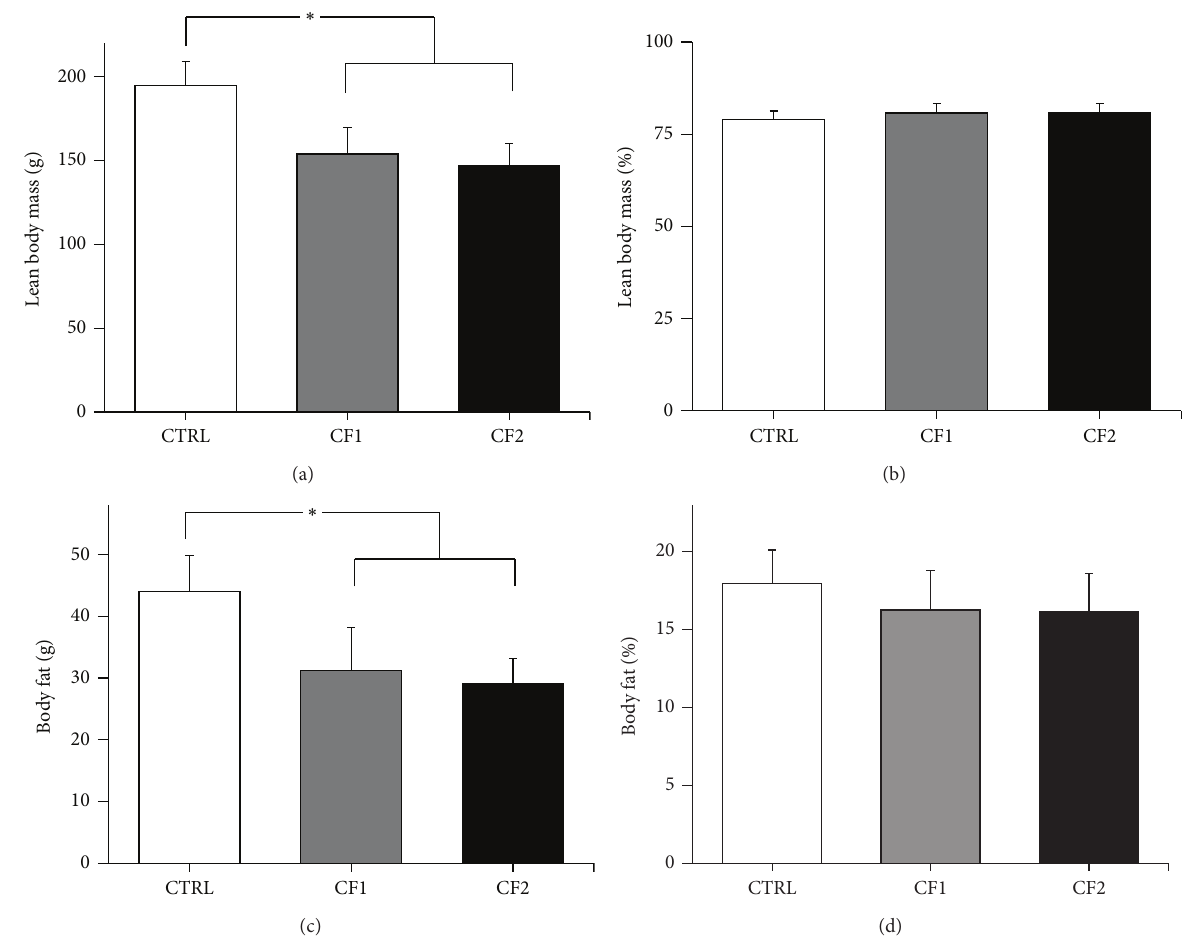
Figure 2: Effect of caffeine exposure on lean body mass and body fat as determined by DXA. Comparison of (a) lean body mass, (b) the percentage of lean body mass, (c) total body fat, and (d) the percentage of body fat between the control and caffeine-fed groups at the end of experiment. Lean body mass (%), lean body mass divided by total body mass; body fat (%), total body fat divided by total body mass. Values are expressed as mean ± SD. CTRL, control; CF1, caffeine 120 mg/kg/day; CF2, caffeine 180mg/kg/day. ∗ 𝑝 < 0.001 versus CTRL.